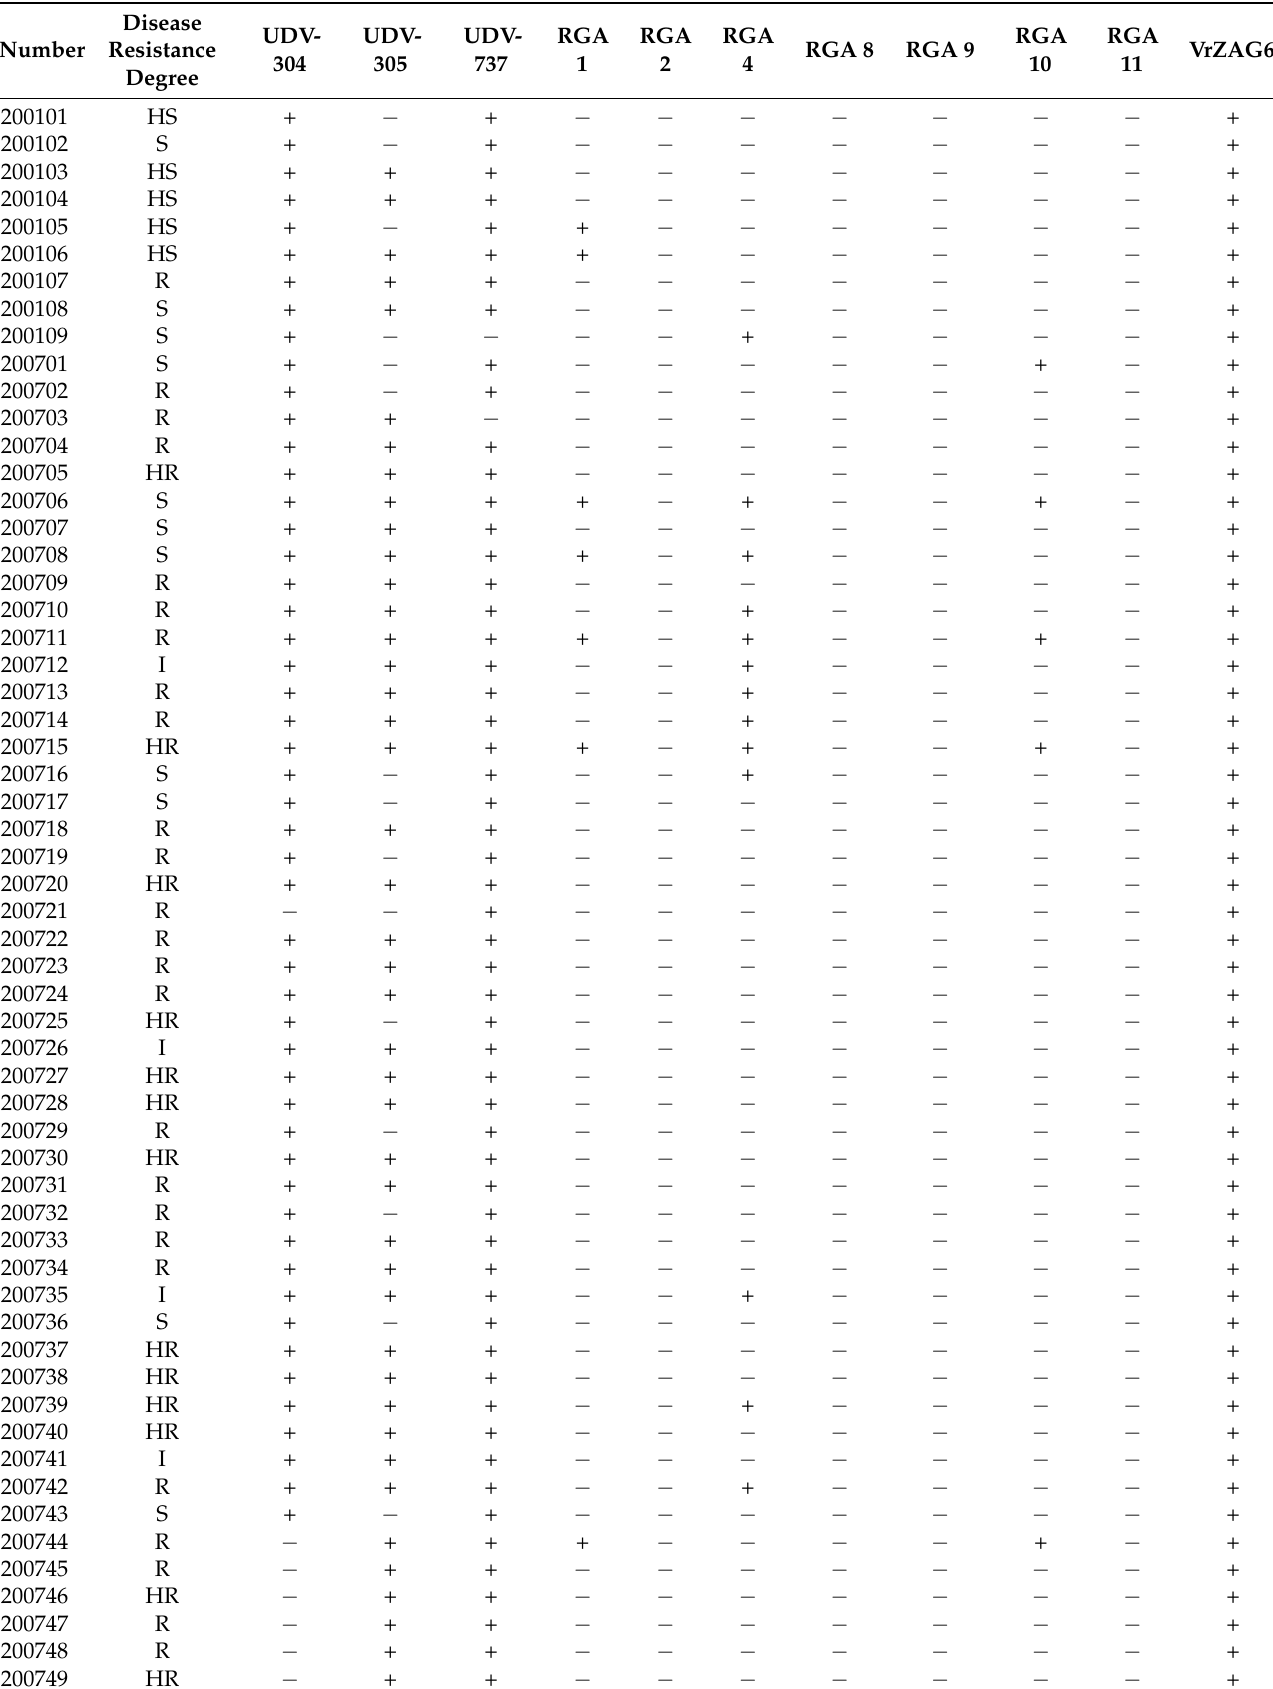
Table 4. Amplification results of nine markers in combination